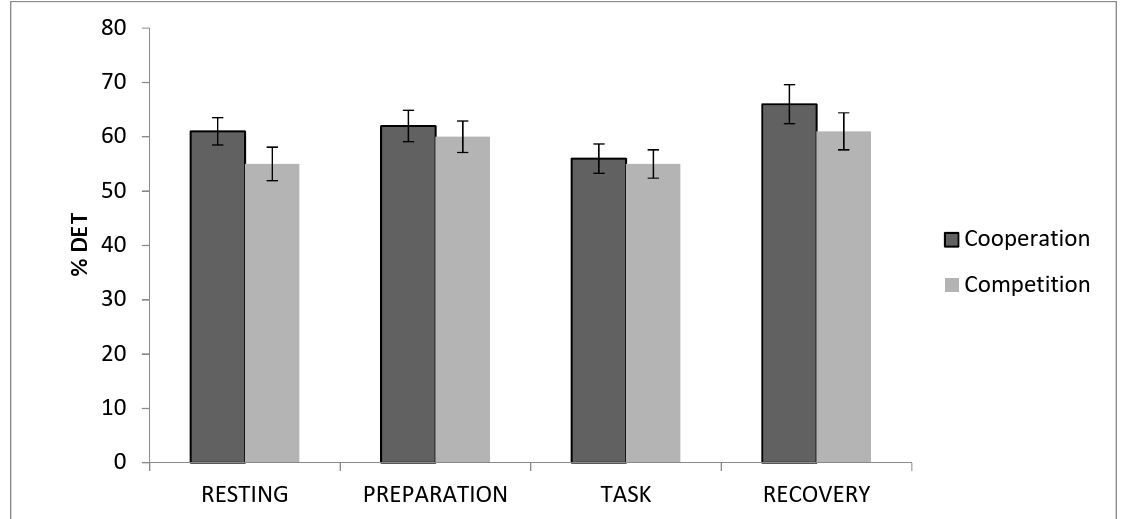
Figure 1. Electrocardiogram (ECG) percentage of determinism values for cooperation and competition groups. Regarding the HR determinism AUC values, there was no significant ‘group’ e ff ect on determinism values (Z = − 1.01; p = 0.313) (Figure 2).